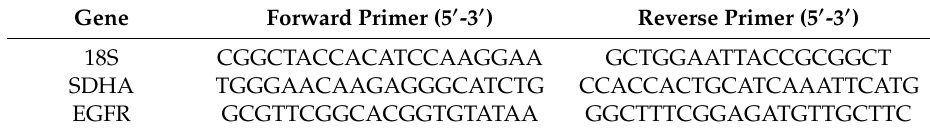
Table 2. Primer pairs used for qPCR. Primer pairs for detection of 18S rRNA, succinate-dehydrogenase complex subunit A (SDHA) and epidermal growth factor receptor